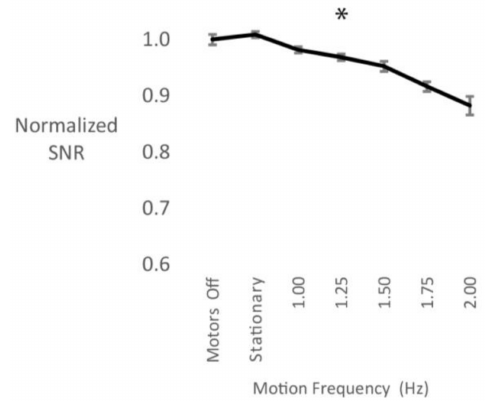
Figure 5. Normalized signal to noise ratio (SNR) values during cable sway. SNR decreased with increasing motion frequency. Error bars represent the standard error of the